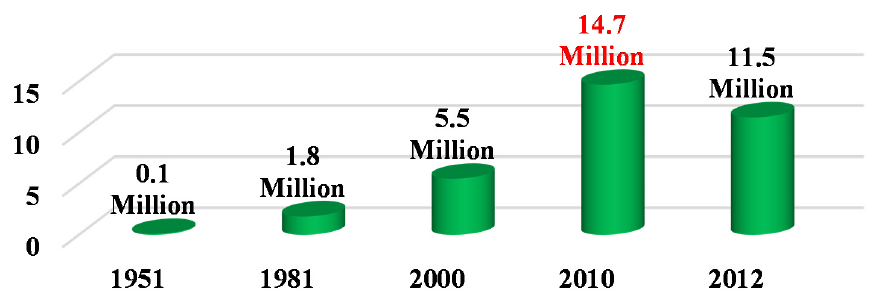
Figure 2. The distribution of number of tourists from 1951 until